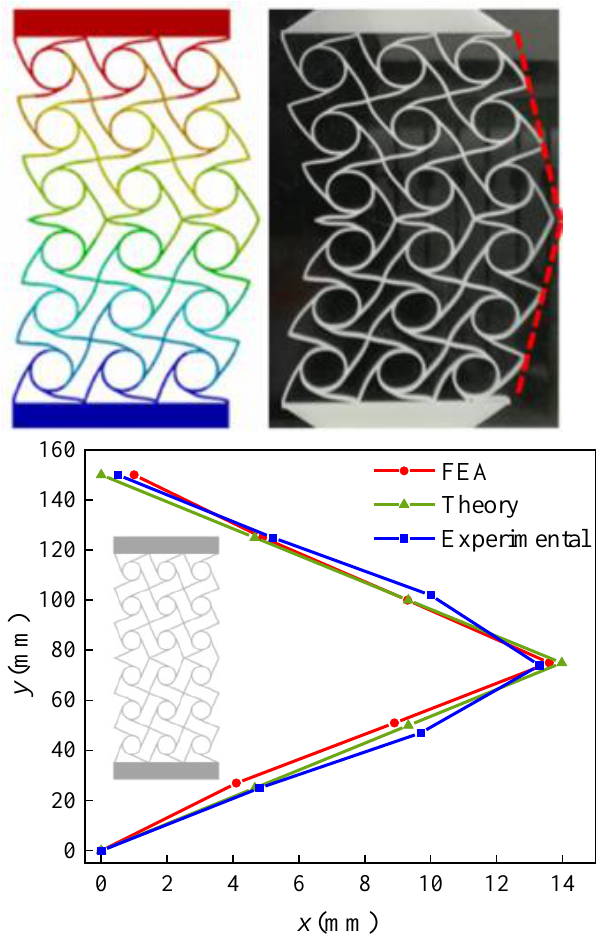
Figure 10. Experimental apparatus. ( a ) 3D printer; ( b ) Universal testing machine.